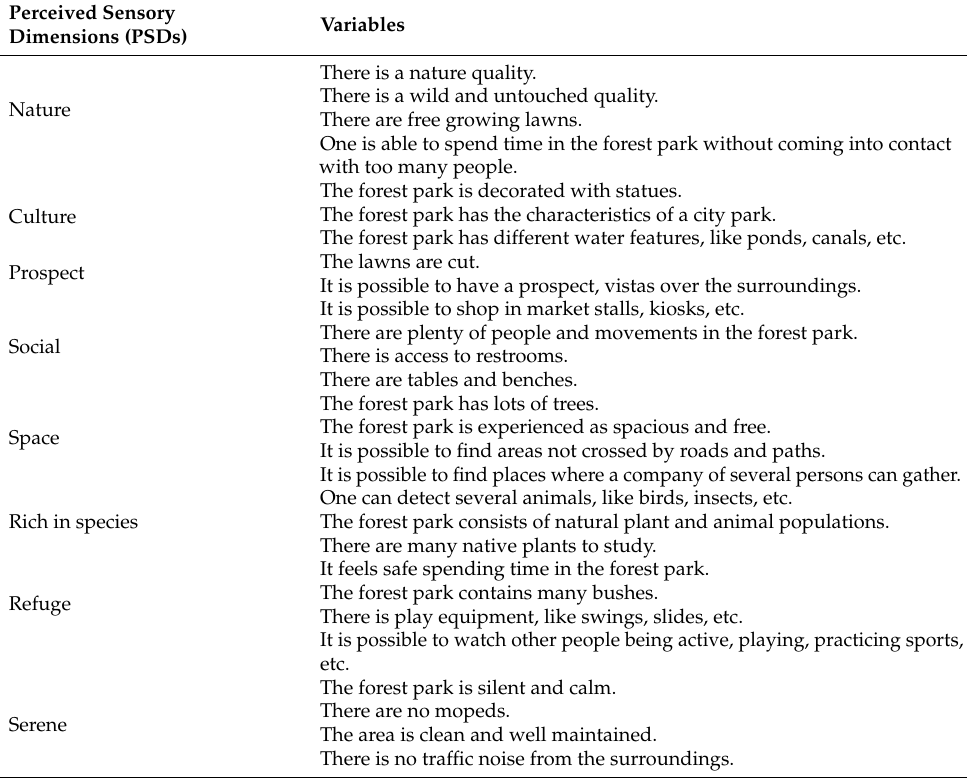
Table 2. Perceived sensory dimensions (PSDs) and corresponding